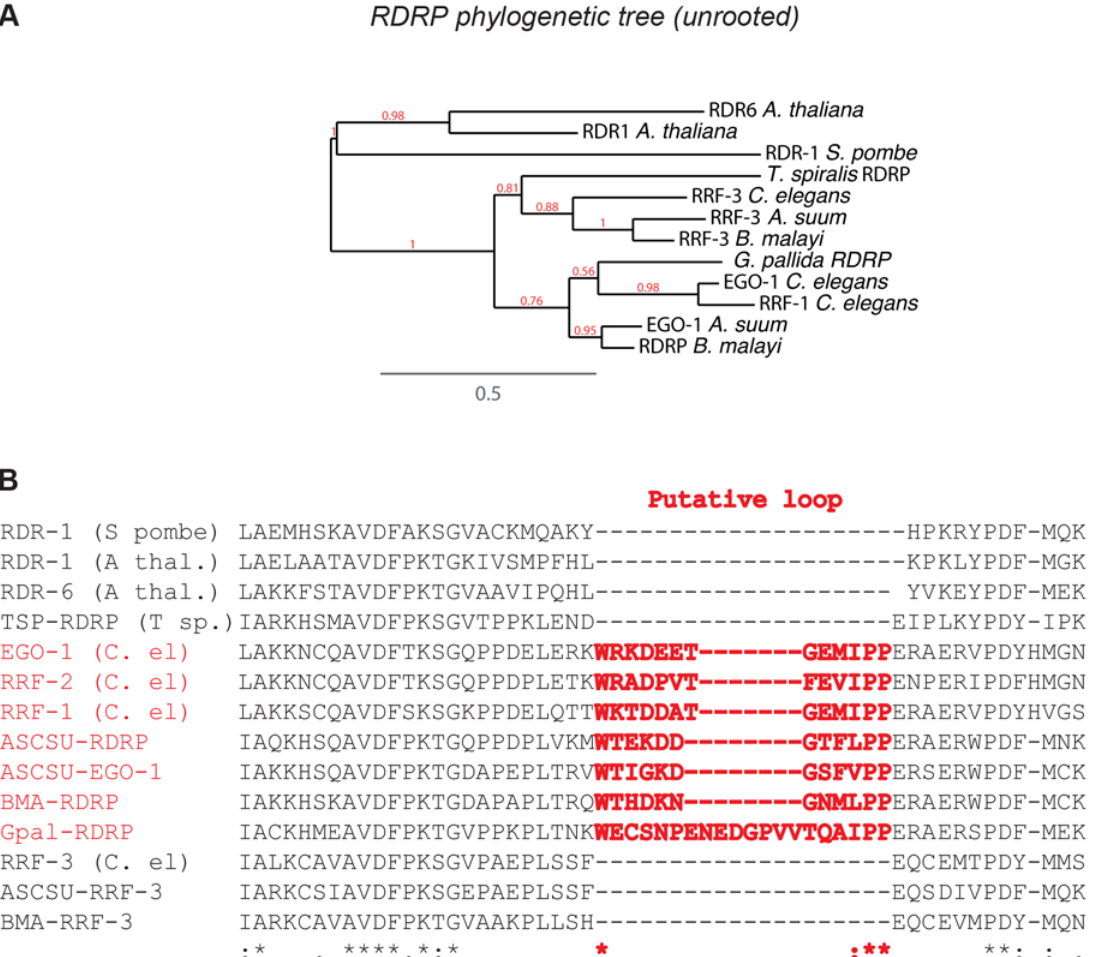
Fig 6. RNA dependent RNA polymerase sequence analysis. (A) Unrooted phylogenetic tree of RNA dependent RNA polymerase sequences from curated nematode genomes, Arabidopsis thaliana , and S . pombe . Whilst nematode RNA dependent RNA polymerases are a distinct class, RRF-3 and RRF- 1/RRF-2/EGO-1 define separate subgroups and only the RRF-3 subgroup is conserved in T . spiralis . Branch support values from 100 bootstraps are shown in red at each bifurcation. The tree file is in S4 Data. (B) A portion of the multiple sequence alignment of RdRP (Muscle) where a conserved, proline-rich loop is inserted in RRF-1/RRF-2/EGO-1 family polymerases, not present in either RRF-3 family RdRPs or in plant or fungal RdRPs. The full sequence alignment is in S2 Data.